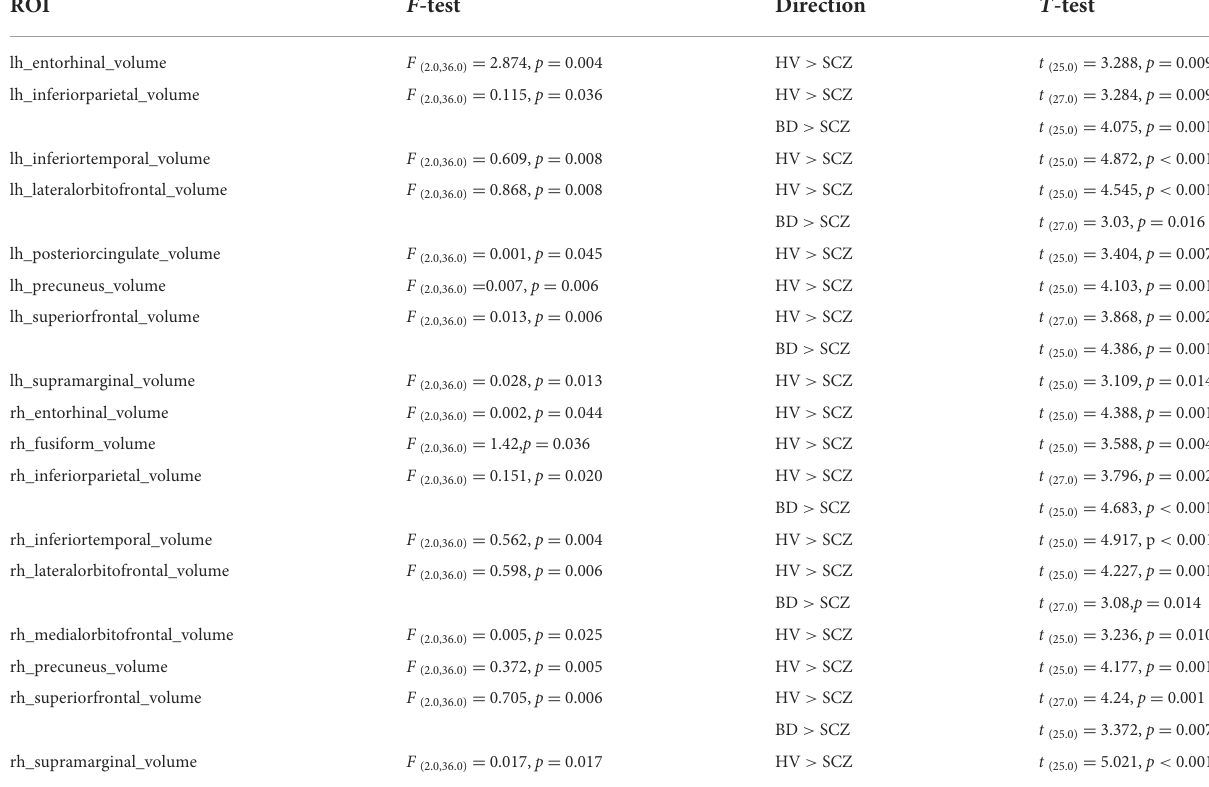
TABLE 4 Volumetric brain regions showing significant differences by diagnostic